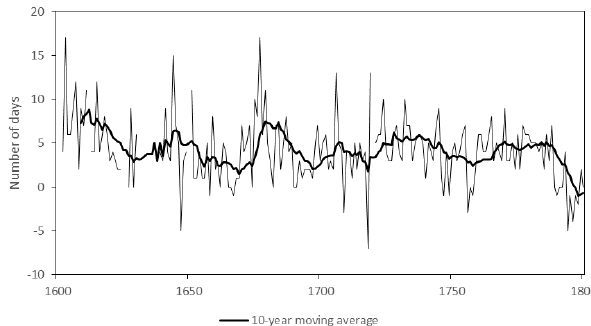
Figure 4. Time interval between the GHDs of Dijon and the GHDs of Beaune